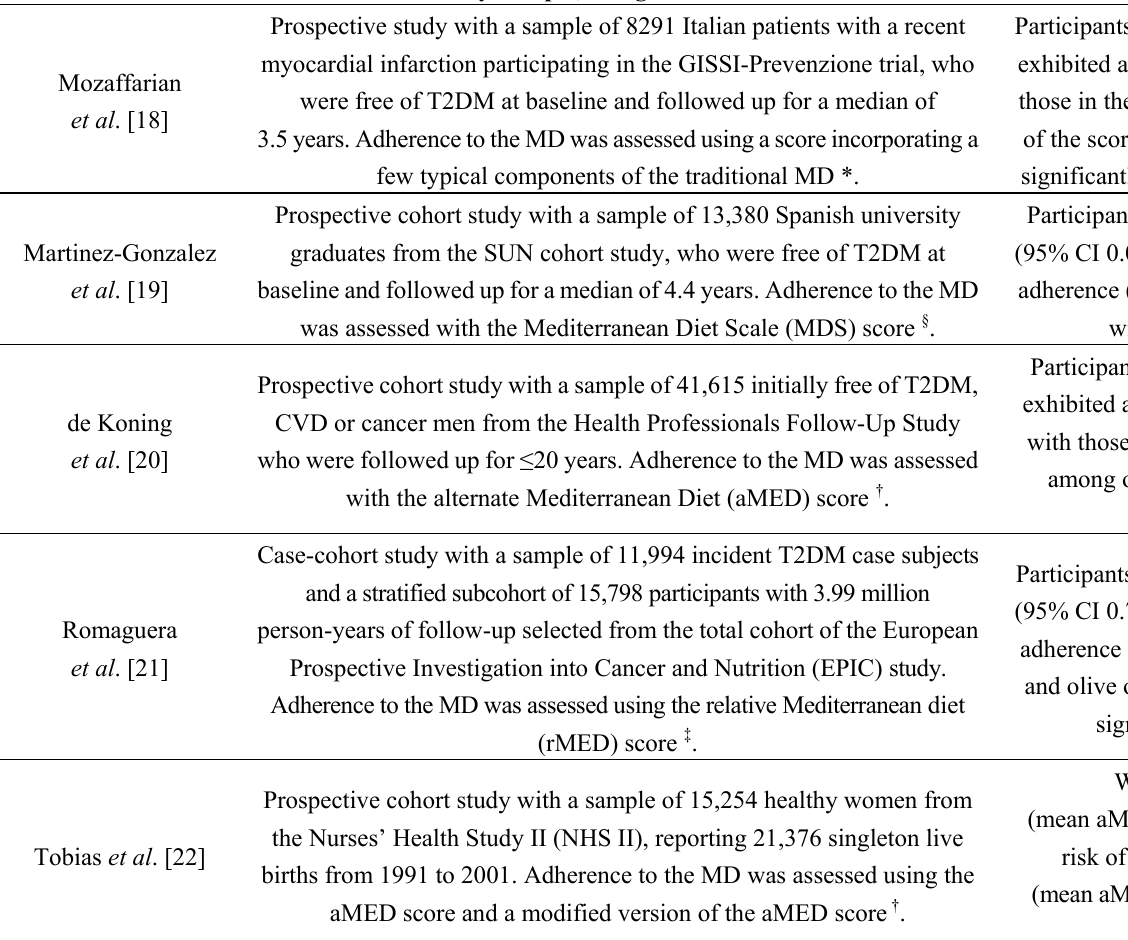
Table 1. Studies with prospective design exploring the association between adherence to the Mediterranean diet and risk of diabetes mellitus.